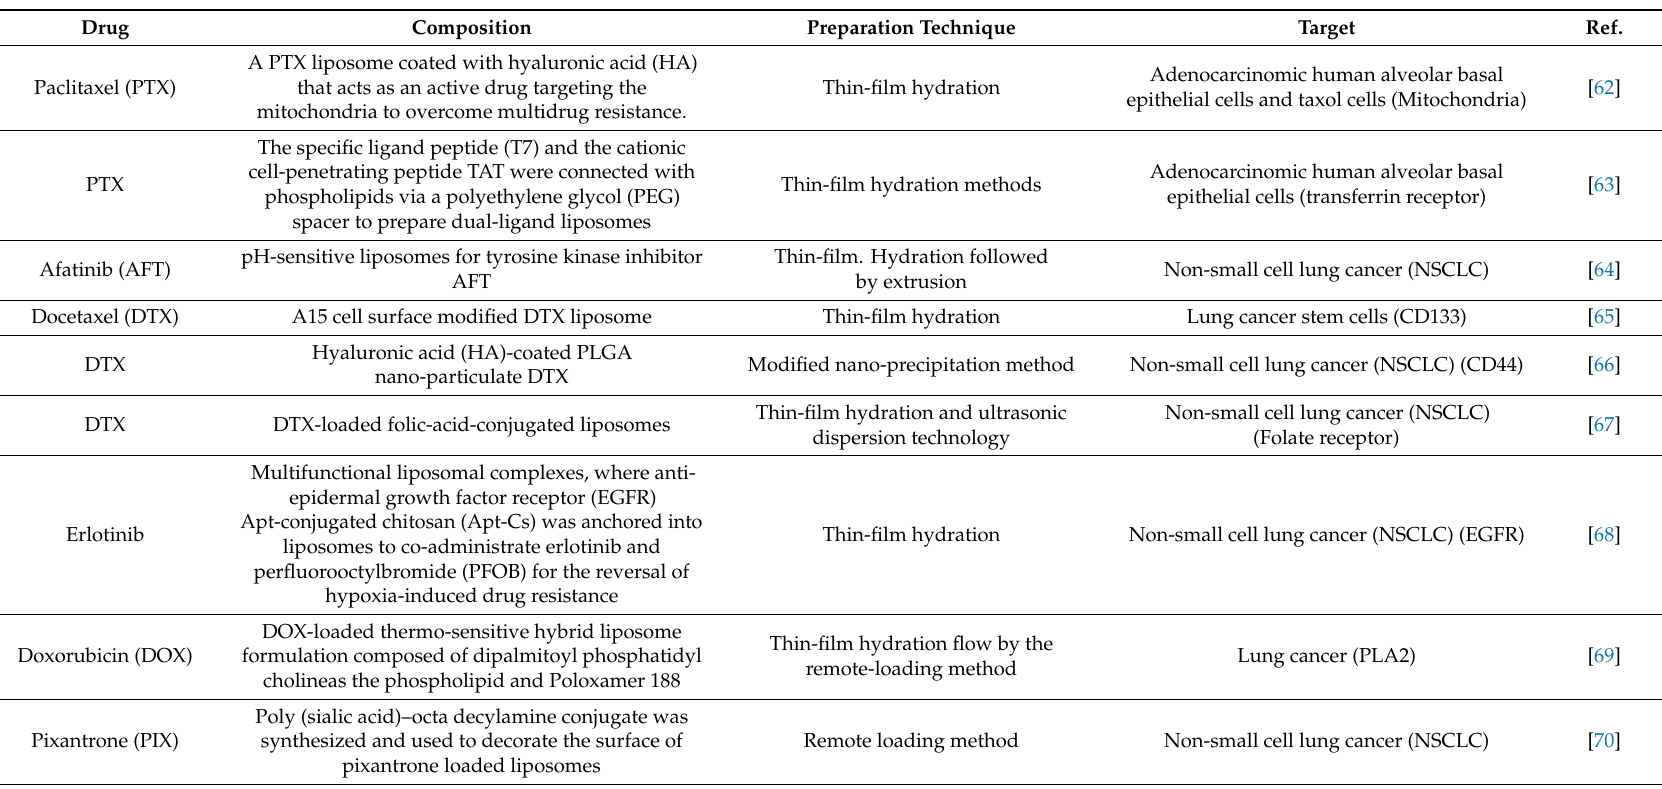
Table 1. Nano-liposome encapsulating di ff erent types of drugs for the treatment of lung